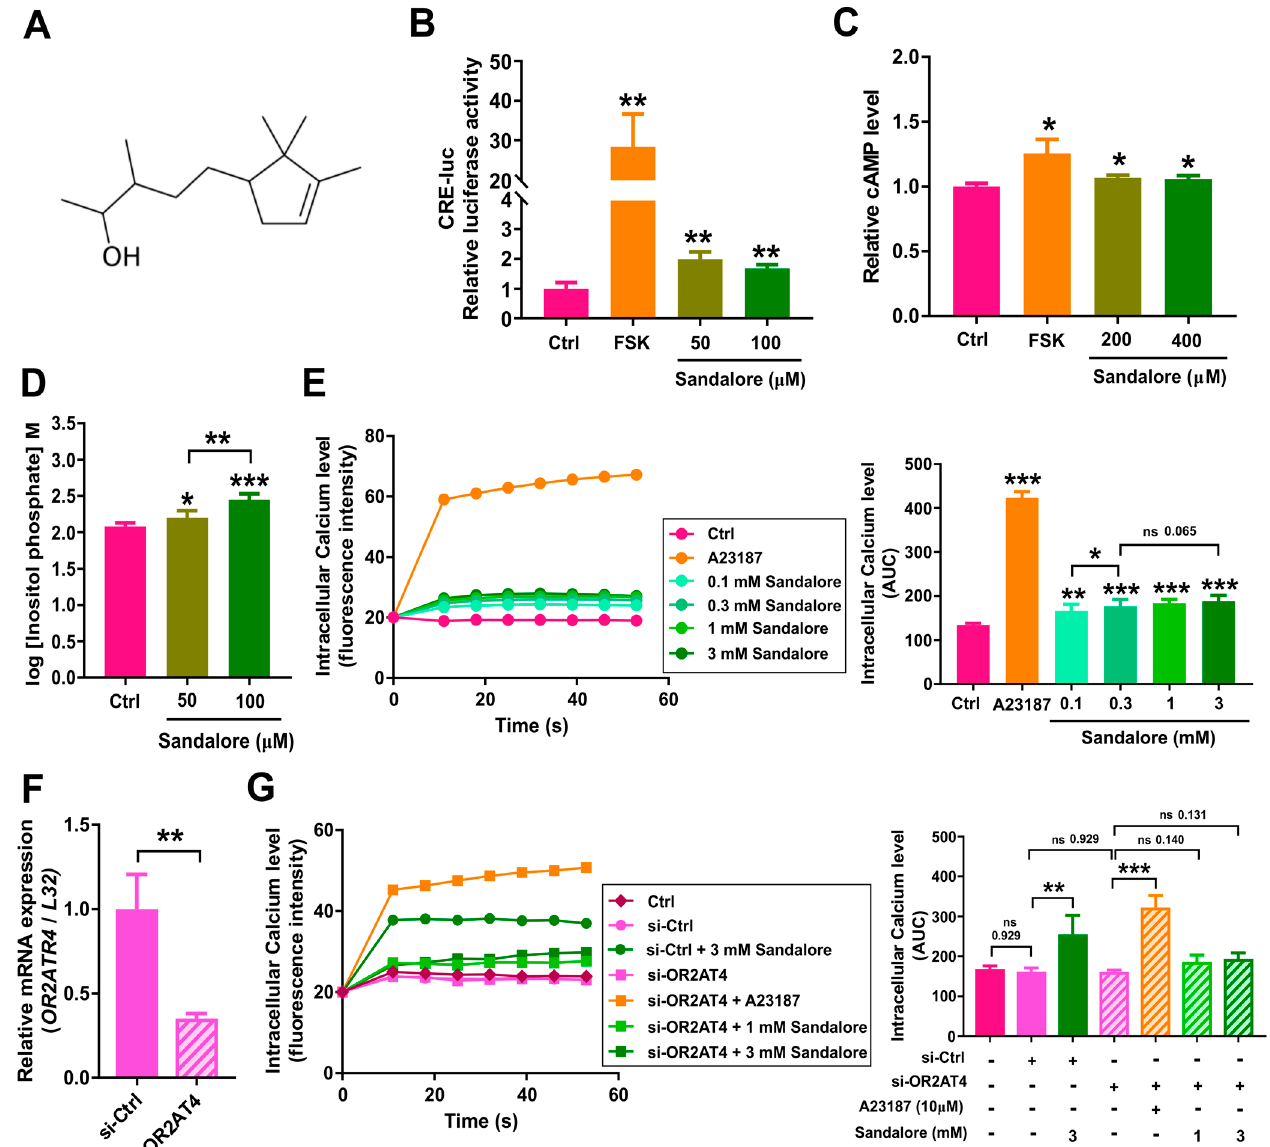
Figure 2. Second messenger analysis and CRE activity measurements in HaCaT cells treated with sandalore. ( A ) Chemical structure of sandalore. ( B ) CRE-luciferase activity in Hana3A cells trans- fected with OR2AT4. ( C ) Relative cAMP, ( D ) inositol phosphate, and ( E ) intracellular calcium levels in HaCaT cells treated with sandalore. ( F ) OR2AT4 mRNA expression in cells transfected with siRNAs. si-Ctrl, HaCaT cells transfected with control siRNA; si-OR2AT4, HaCaT cells transfected with OR2AT4 siRNA. ( G ) Intracellular calcium levels in HaCaT cells with OR2AT4 knockdown. Ctrl, control; FSK, 1 µM forskolin; A23187, 10 µM calcium-ionophore; AUC, area under curve. Data are means ± SEM. * p < 0.05, ** p < 0.01, and *** p < 0.001. Student’s t -test was performed for comparisons between groups.